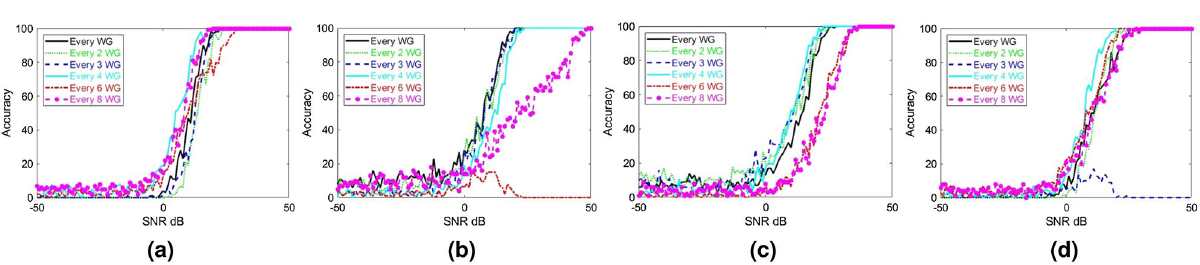
Figure 4. AoA estimation accuracy (in percentage) for wave incident at ( a ) − 47 ◦ , ( b ) − 18 ◦ , ( c ) 10 ◦ , and ( d ) 40 ◦ , calculated with different numbers of uniformly spaced waveguides (WG).